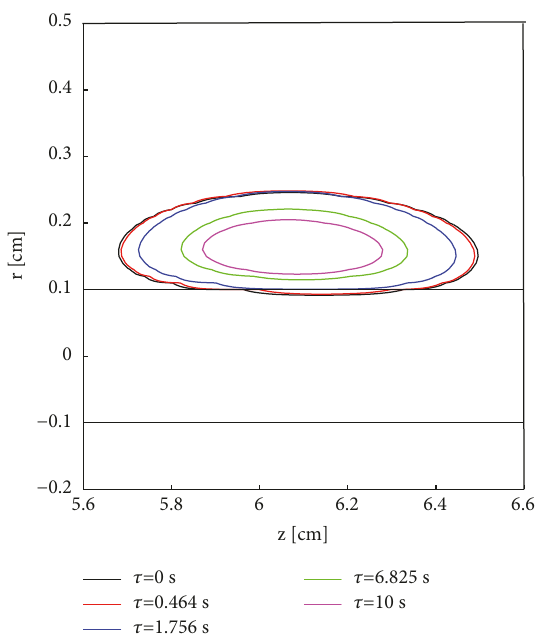
peak temperatures in space 𝑟, 𝑧 ∈ Ω are 87.258 ∘ C, 82.432 ∘ C, 73.209 ∘ C, 61.88 ∘ C, 58.872 ∘ C at time 1𝑠 , 1.565 𝑠 , 2.939 𝑠 , 5.87 𝑠 , 7.147 𝑠 for 𝜏 = 0 , 0.464 , 1.756 , 6.825 , 10 𝑠 ,